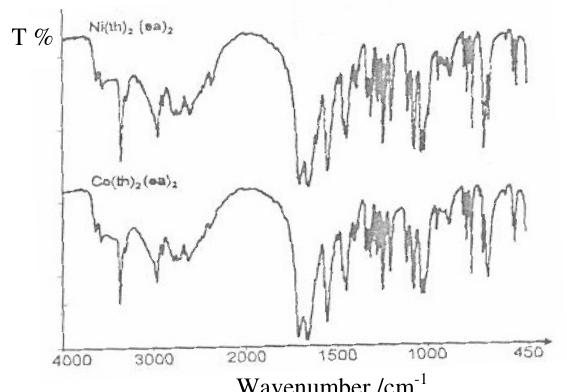
Figure 3. FTIR spectra of [Co (th)